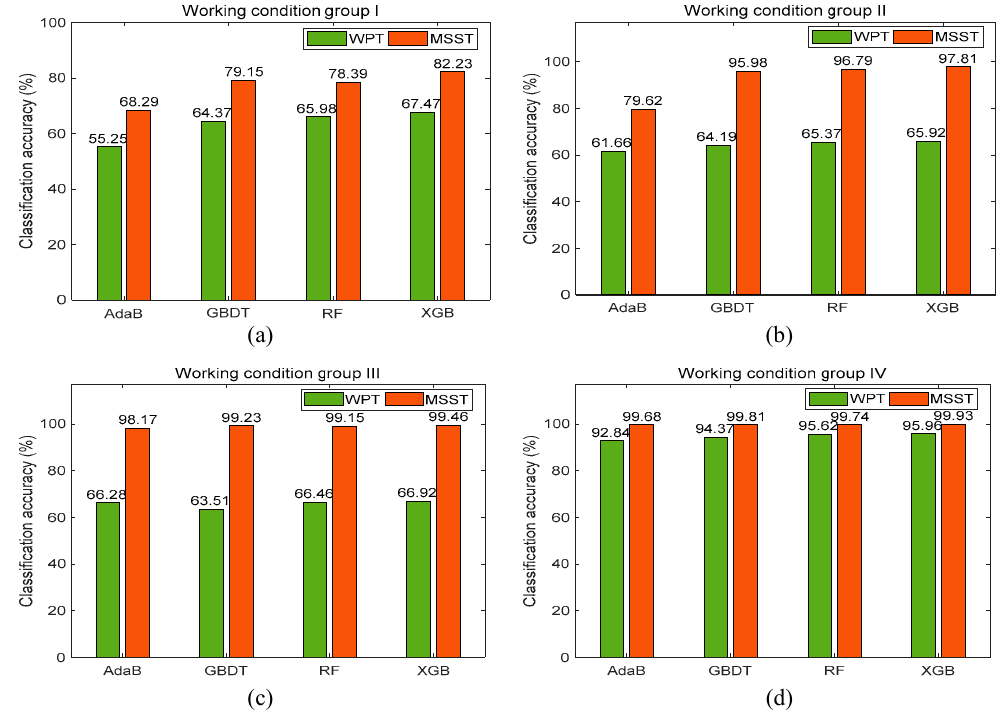
Figure 9. Classification results of the test set under di ff erent working conditions: ( a ) Working condition group I; ( b ) Working condition group II; ( c ) Working condition group III; ( d ) Working condition group IV.